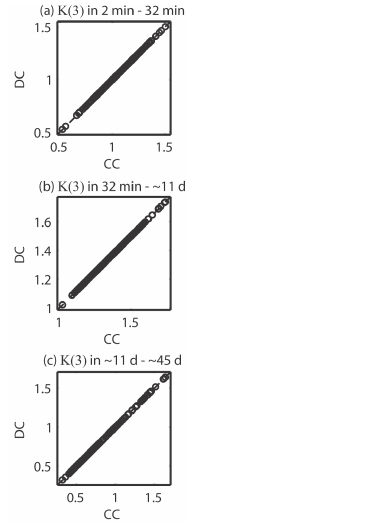
Fig. 12. Scatter plots between the multifractal exponents K( 3 ) com- puted for the signal sampled with CC (x-axis) and DC (y-axis) methods. Each panel refers to a given scaling regime. Fig. A1. Qualitative example illustrating the construction of the